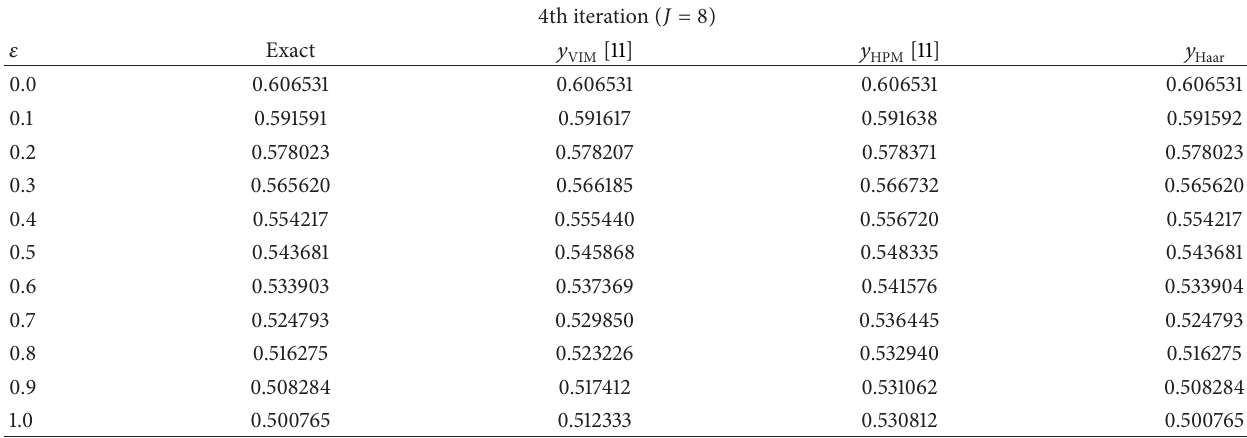
Table 3: Numerical results for cooling equation for different 𝜀 and 𝑥 = 0.5 : Haar wavelet-quasilinearization technique at 4th iteration and level of resolutions 𝐽 = 8 .